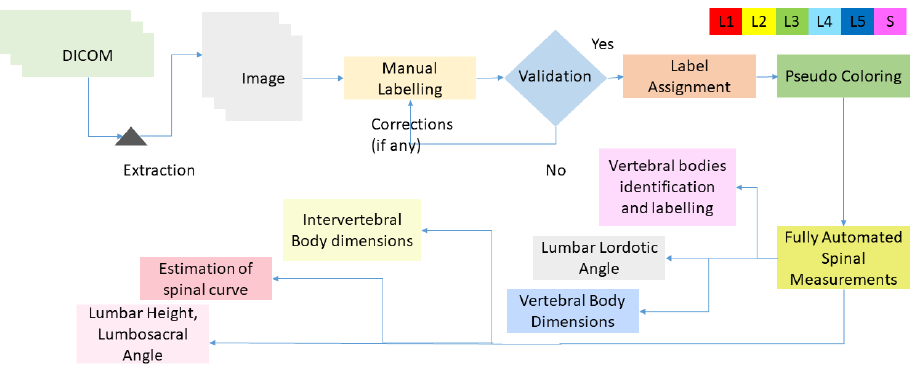
Figure 3. Flow diagram representing the extraction of images, manual labeling and validation, pseudo-coloring, and performing automated spinal